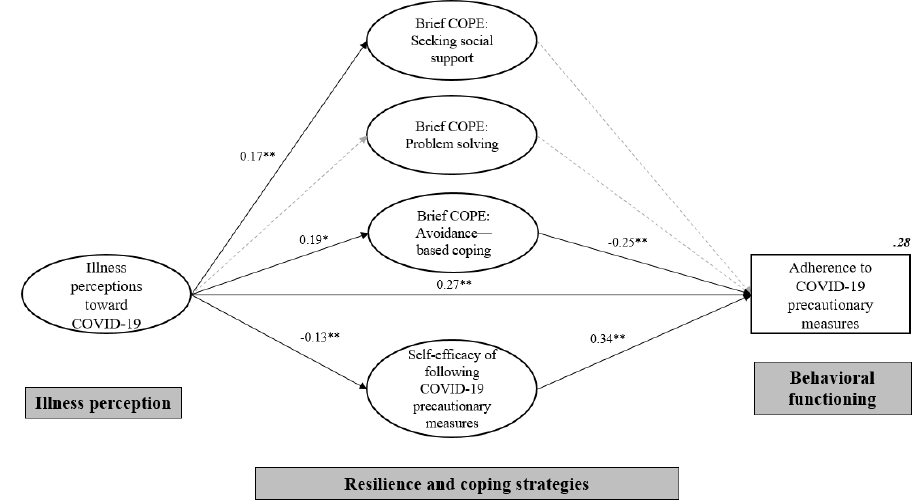
Figure 1. A structural equation model. Latent variables are represented by ellipses. Solid lines indicate significant paths of direct effects, dashed lines indicate non-significant paths of direct effects. For simplicity, the observed variables and covariance paths for all latent variables were not displayed. Model was adjusted for gender (male/female). All coefficients are standardized. Abbreviations: Brief